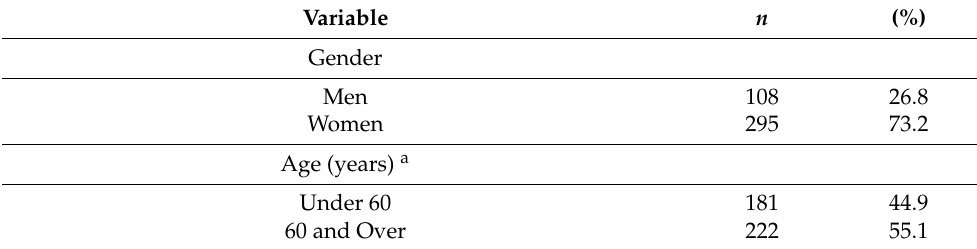
Table 1. Sample characteristics ( n =